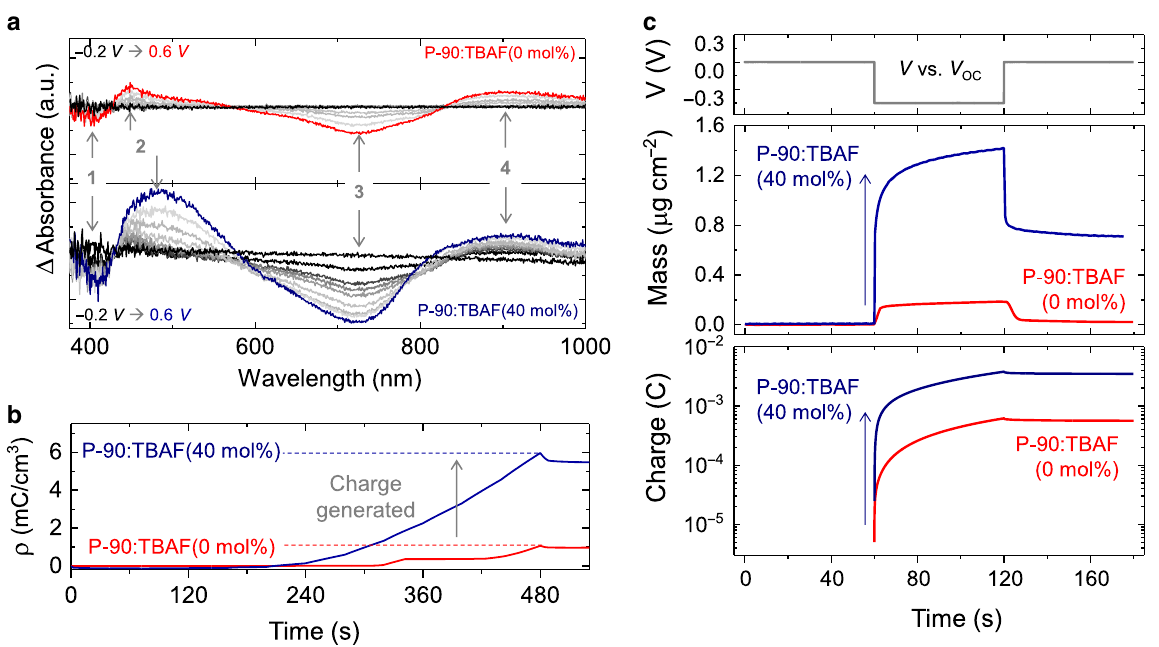
Fig. 3 Impact of molecular n-doping on electrochemical doping. a Spectroelectrochemistry measurements showing UV-vis absorption spectra changes with applied voltage (from − 0.2 V to 0.6 V in 0.1 V increments) for the pristine P-90 system (0 mol% TBAF), compared to the best-performing, n-doped P-90:TBAF system (40 mol% TBAF). b Charge density in 0 mol% TBAF and 40 mol% TBAF thin- fi lms, generated under electrochemical doping potentials applied during spectroelectrochemistry measurements. All measurements are carried out whilst the polymer thin- fi lms are submerged in an aqueous 100 mM NaCl electrolyte solution, and the thin- fi lm thicknesses are given in Table 1. c Electrochemical quartz crystal microbalance with dissipation (EQCM-D) monitoring for the pristine P-90 and best-performing P-90:TBAF systems, whilst exposed to 0.1 M NaCl (aq.) electrolyte at an electrochemical- doping potential of 0.45 V vs. V OC